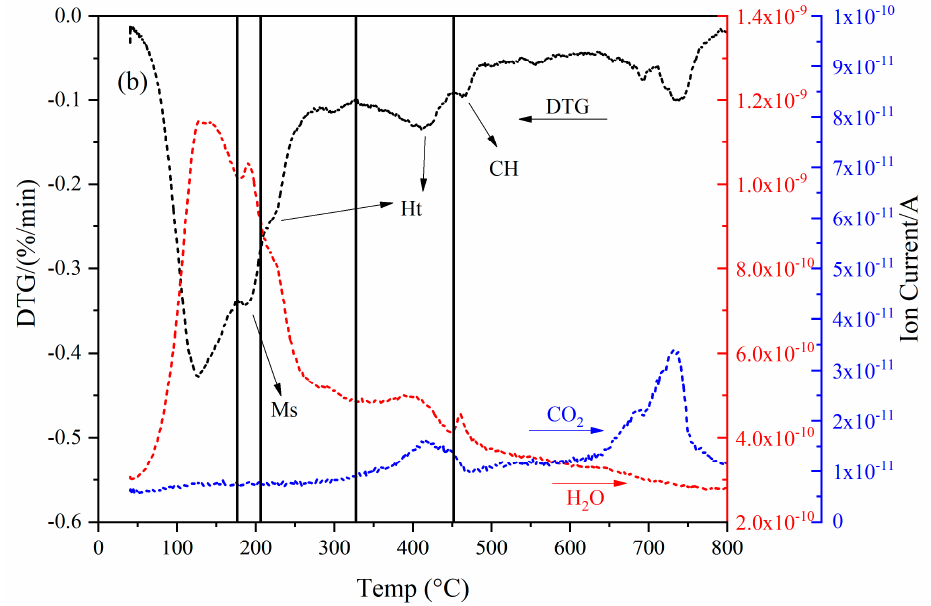
Figure 1. The DTG results, H 2 O and CO 2 MS curves of ( a ) sample A and ( b ) sample B, respectively. CH: portlandite; Ht: hydrotalcite-like phase; Ms: calcium monosulfoaluminate.